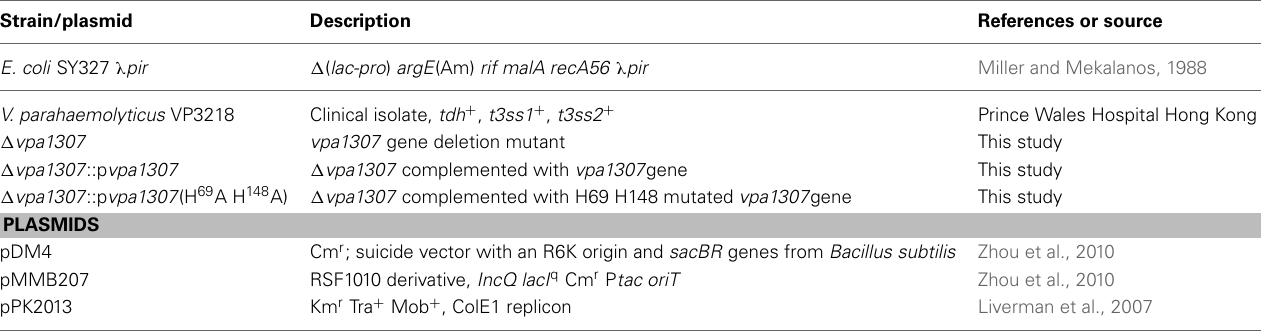
Table 1 | Bacteria and plasmids used in this study.